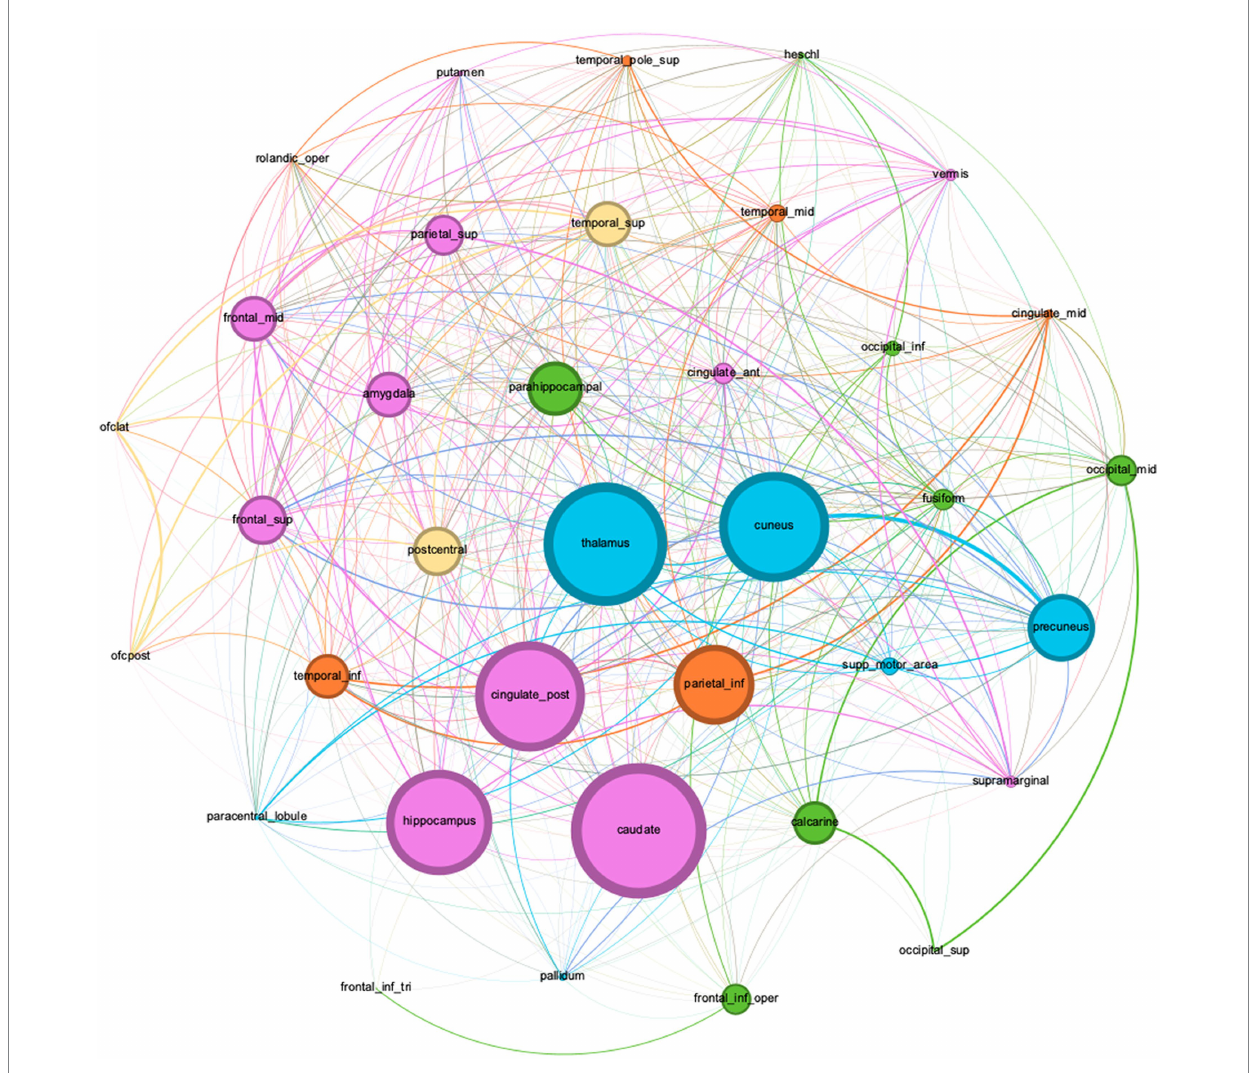
FIGURE 3 Graph network visualization of dictionary terms found in the full-texts subgroup corpus (Corpus 4).